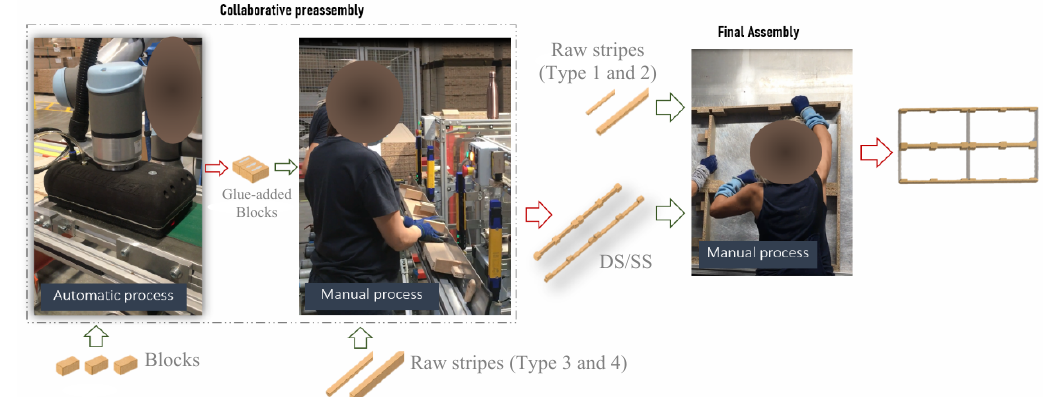
Figure 4 New assembly workflow (inputs, examples of postures adopted, outputs).